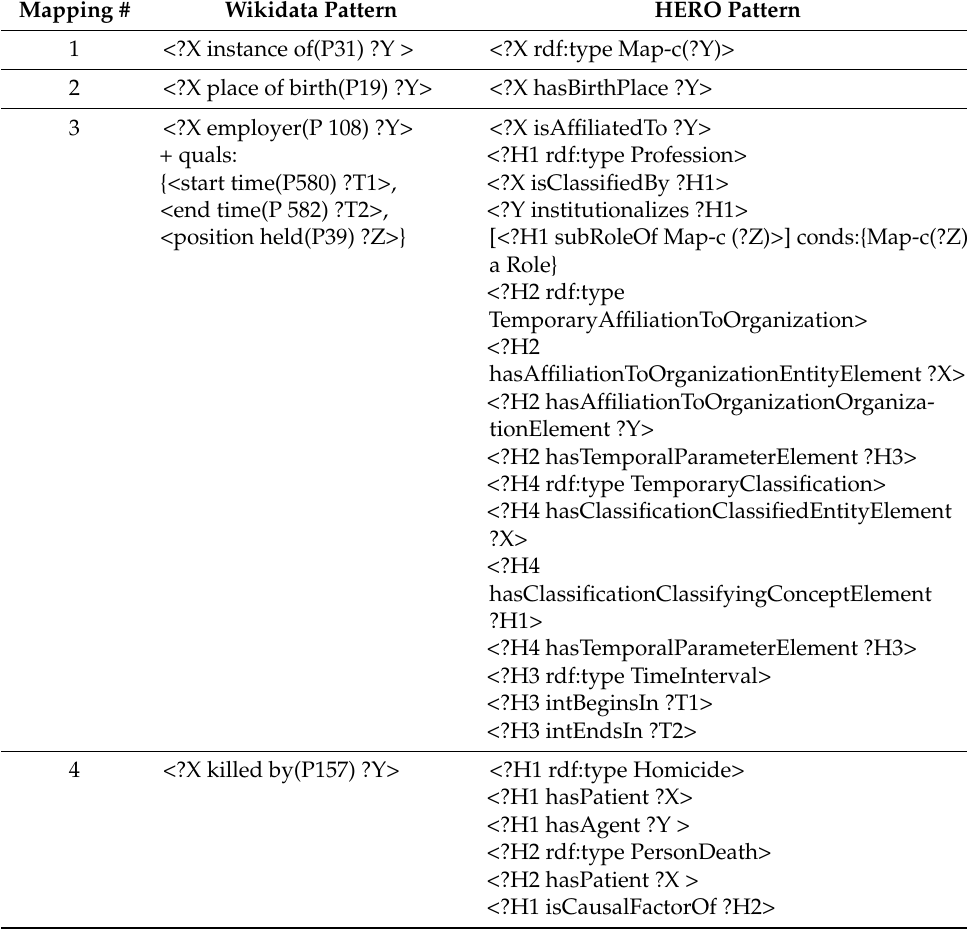
Table 3. Four sample mappings from Wikidata description patterns to HERO ones. Variables are prefixed with the question mark (e.g., ?X ). Variables occurring in Wikidata patterns are intended as universally quantified, while those occurring only in HERO patterns are intended as existentially quantified. For the sake of readability, the latter are named ?H1, . . . ?H4 . Map-c(?Y) is the result of the mapping of the Wikidata category ?Y to a HERO category; in mapping 3, quals indicates Wikidata qualifiers, and conds expresses conditions for the associated optional triple to be